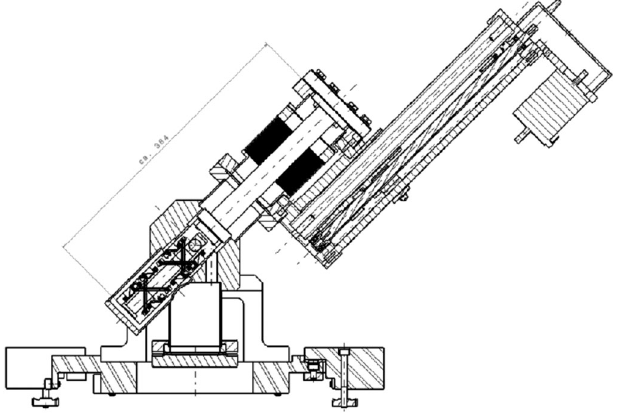
FIG. 1. View of the transverse section of the in-vacuum setup of the SwissFEL WSC: CF16 vacuum chamber, motorized UHV- Linear-Stage and wire fork. The SwissFEL wire-fork can be equipped with two triplets of wires. Thanks to a system of multiple pin slots, the horizontal and the vertical wires of each triplet can be set, respectively, at a distance from the center of the vacuum chamber of either 8 mm or 5.5 mm or 3 mm, see also Fig. 2. In order to outline this feature of the SwissFEL wire-fork — in both Figs. 1 and 2 — all the three pin slots are virtually provided with wires. In the real wire-fork of SwissFEL, only one wire is fixed along the horizontal direction by means of one of the three possible pin slots (the same for the vertical